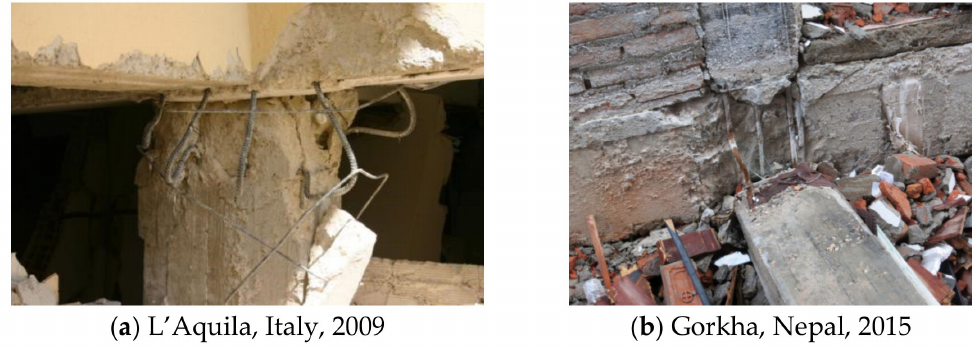
Figure 8. Damage type 5—example of post-earthquake damage in beam-column RC joints: ( a ) strong beam-weak column mechanism and ( b ) absence of transverse reinforcement in the beam- column